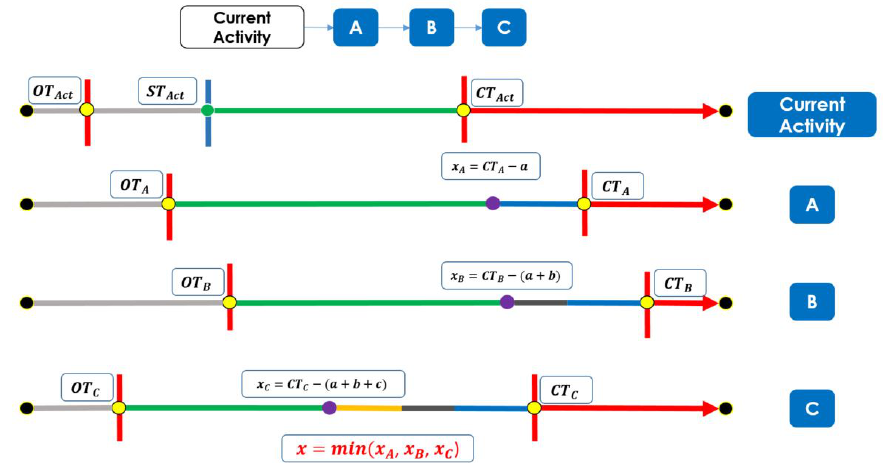
Figure 5. Illustration of minimum latest remaining activities start-time with travel time and duration. The following case is proposed. A user starts the current activity Act at ST Act , and he must decide the end-time of this activity based on A , B and C . Each activity has a typical duration and a time-window (opening and closing time) [ OT − CT ] . The process is applied as follows: Firstly, the proposed value x A (latest remaining activities start-time with travel time and duration of the activity A ) is calculated, the value a references the sum of travel time from Act to A and the typical duration of A ; x A references the subtraction of the travel time from latest start-time of A . Secondly, x B is calculated for the activity B , the value b references the sum of travel time from A to B , duration of B , and the calculated a . The same process is applied for x X of the activity C . Minimum latest remaining activities start-time with travel time and duration is then referenced to the minimum value x from the set: x A , x B , and x C